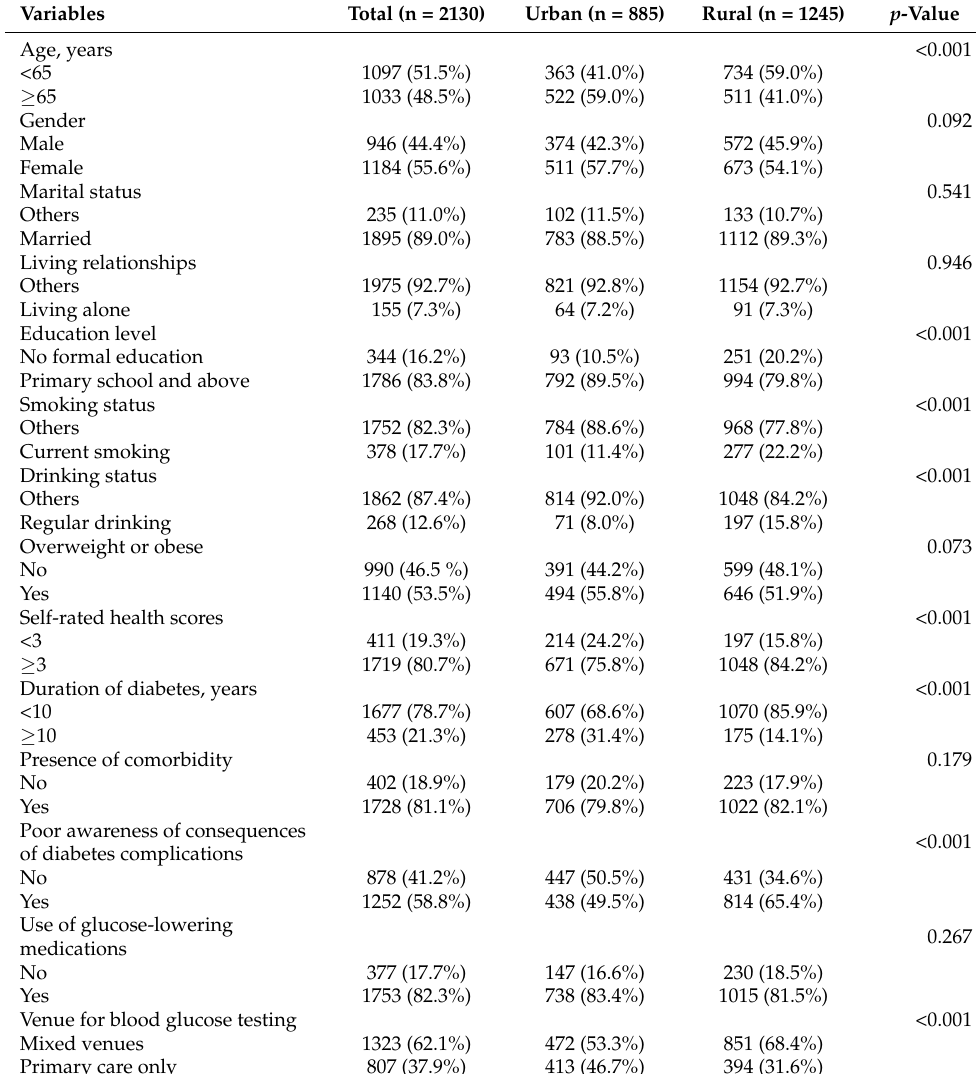
Table 1. Characteristics of study